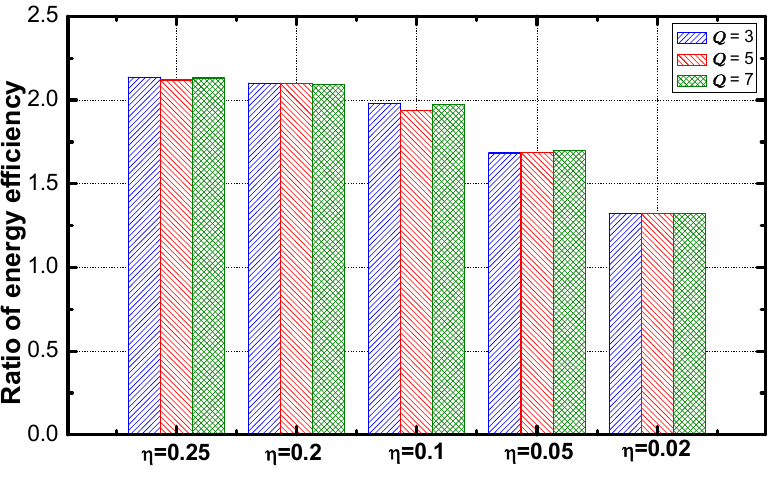
Figure 15. Ratio energy efficiency vs. η .